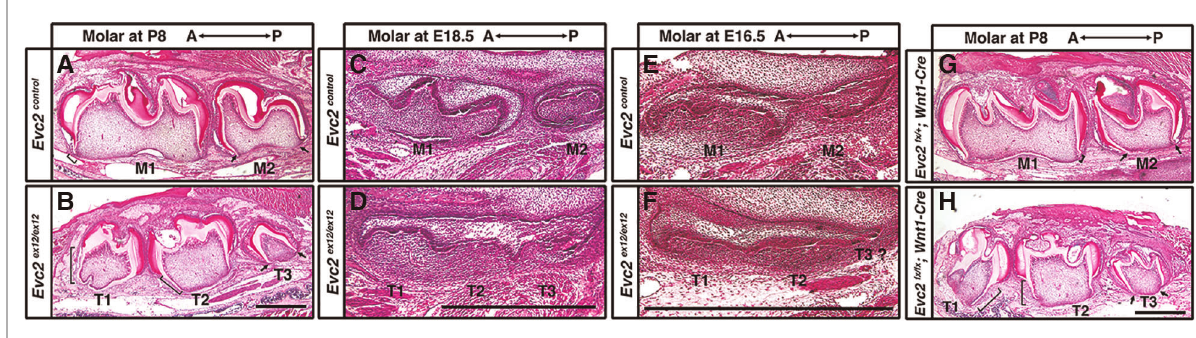
FIGURE 4 Histologic assessment of molars. Molars from control and Evc2 mutant at P8 ( A,B ), E18.5 ( C,D ), E16.5 ( E,F ), molars from controls and Evc2 Wnt mutant at P8 ( H,I ) were sectioned, stained for Hemoxylin and Eosin. Bar=100 µm. ( n =4). Brackets indicate the root and arrows indicate no root